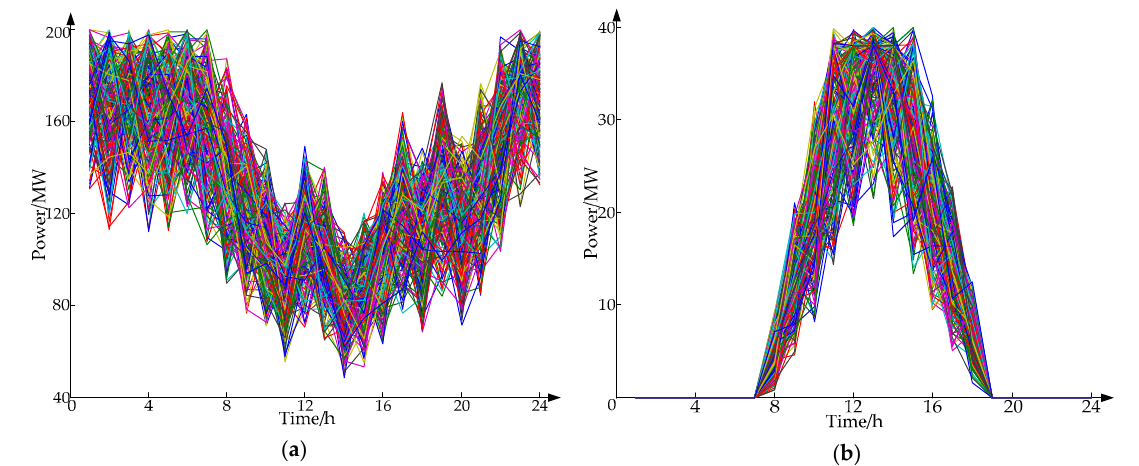
Figure 7. The WP scenarios ( a ) and the PV scenarios ( b ) based on LHS method.